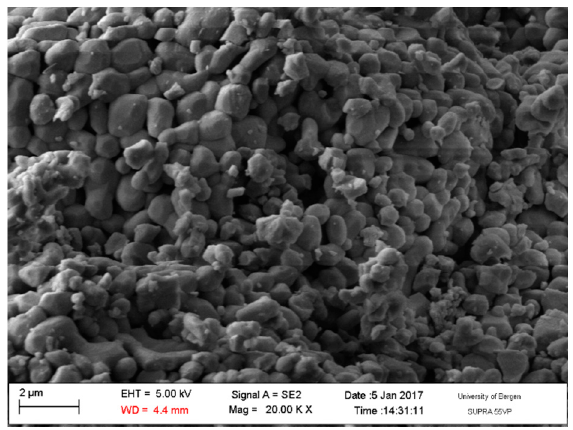
Figure 1. An electron microscopy image of the pore walls of an unhydrated light-burnt lime particle [7].